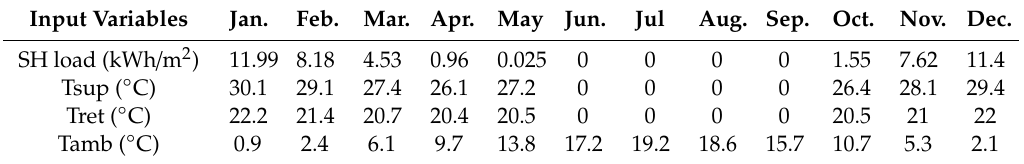
Table 1. Monthly average space heating load, space heating supply and return temperatures for SFH45 under climate of Strasbourg from [18] and ambient temperatures from